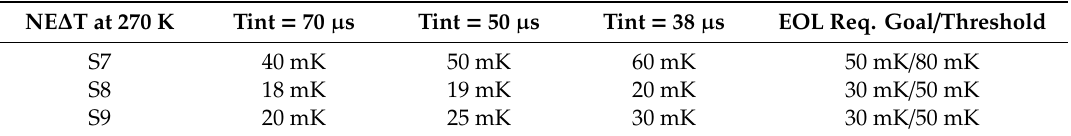
Table 10. SLSTR-A NEDT vs. integration